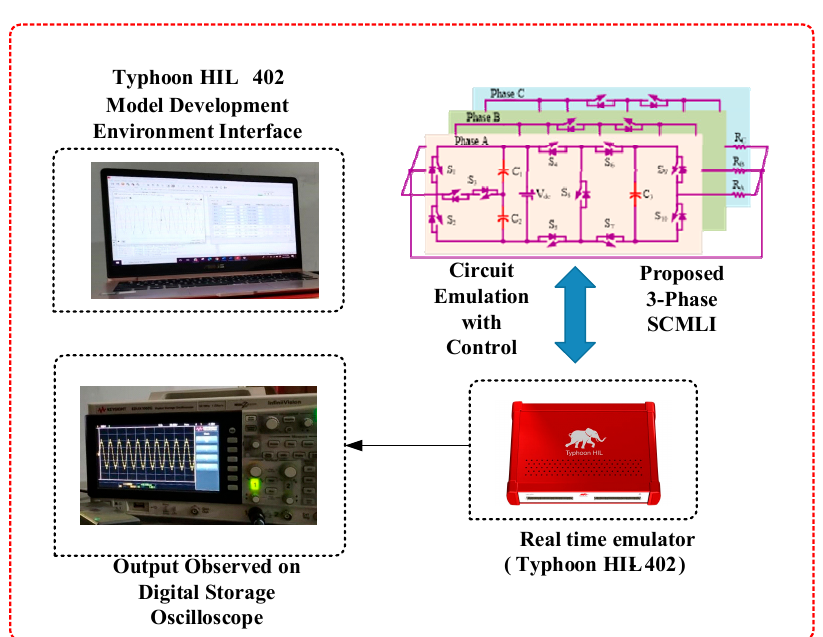
Figure 14. Real-time implementation of the proposed three-phase SCMLI with an SOS-SHE modulation scheme.